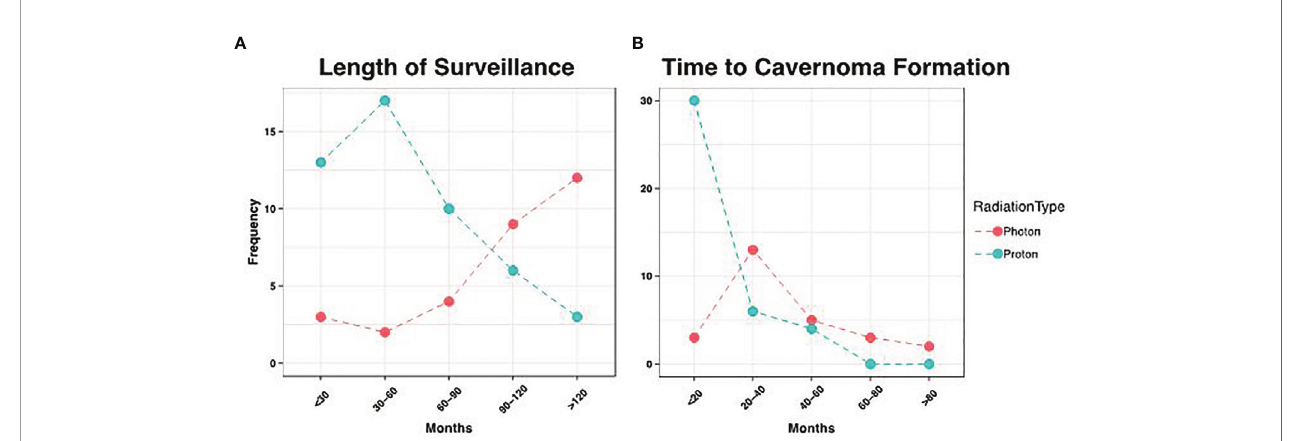
FIGURE 3 | Distribution of Surveillance and Cavemoma Formation. (A) Patients that received photon therapy had longer length of surveillance relative to proton patients, consistent with more recent use of the latter modality (p= 7.28 x 10 -6 ). (B) However, proton patients had earlier development of cavemomas, with an average time to formation of 18.1 months, vs. 40.2 months in photon patients (p = 2.01 x 10 -4 ).